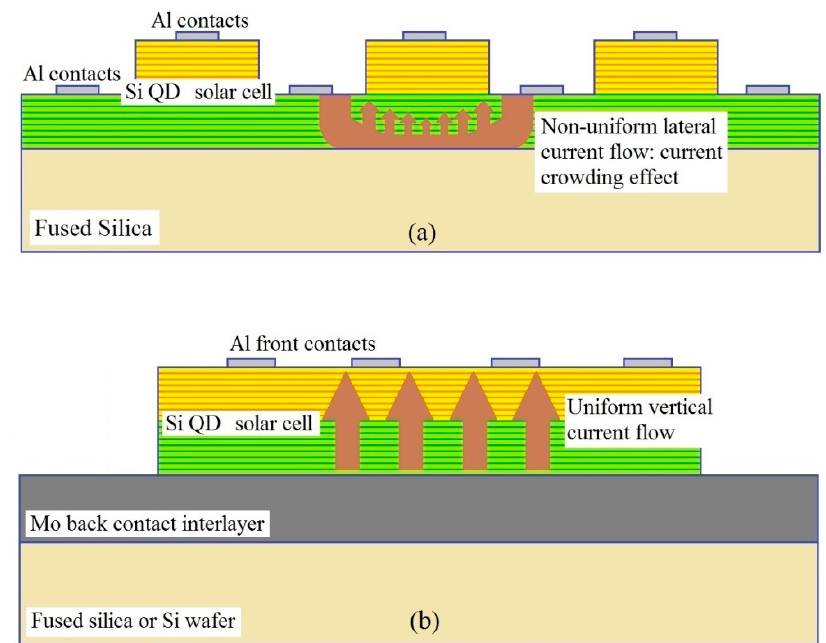
Figure 1. Schematic diagram of ( a ) mesa-structured and ( b ) vertical structured Si quantum dot (QDs) solar cells (not to scale). Current flows are also indicated.